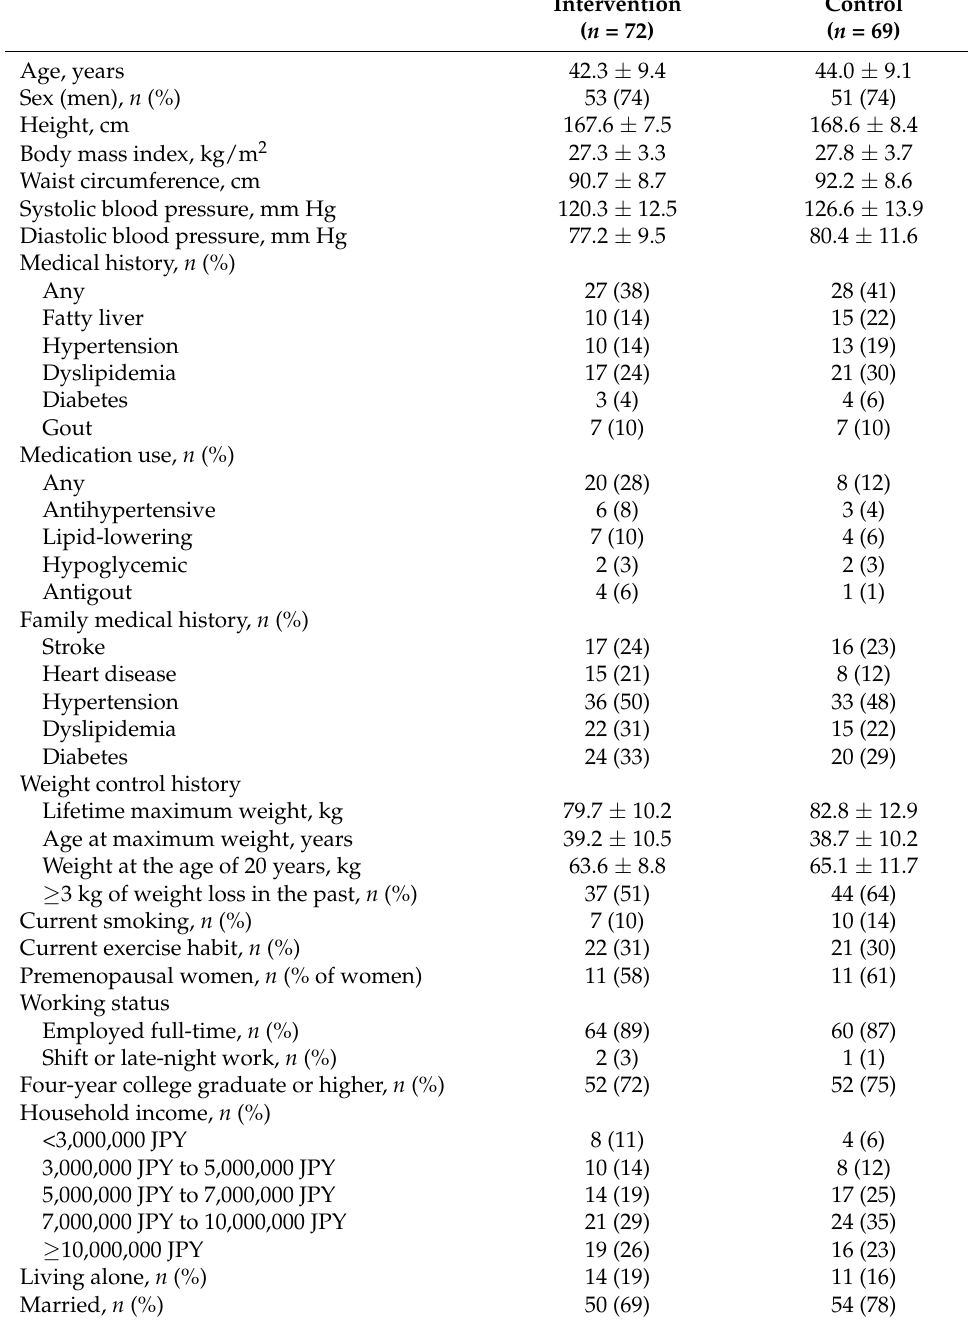
Table 1. Participants’ baseline characteristics by the assigned